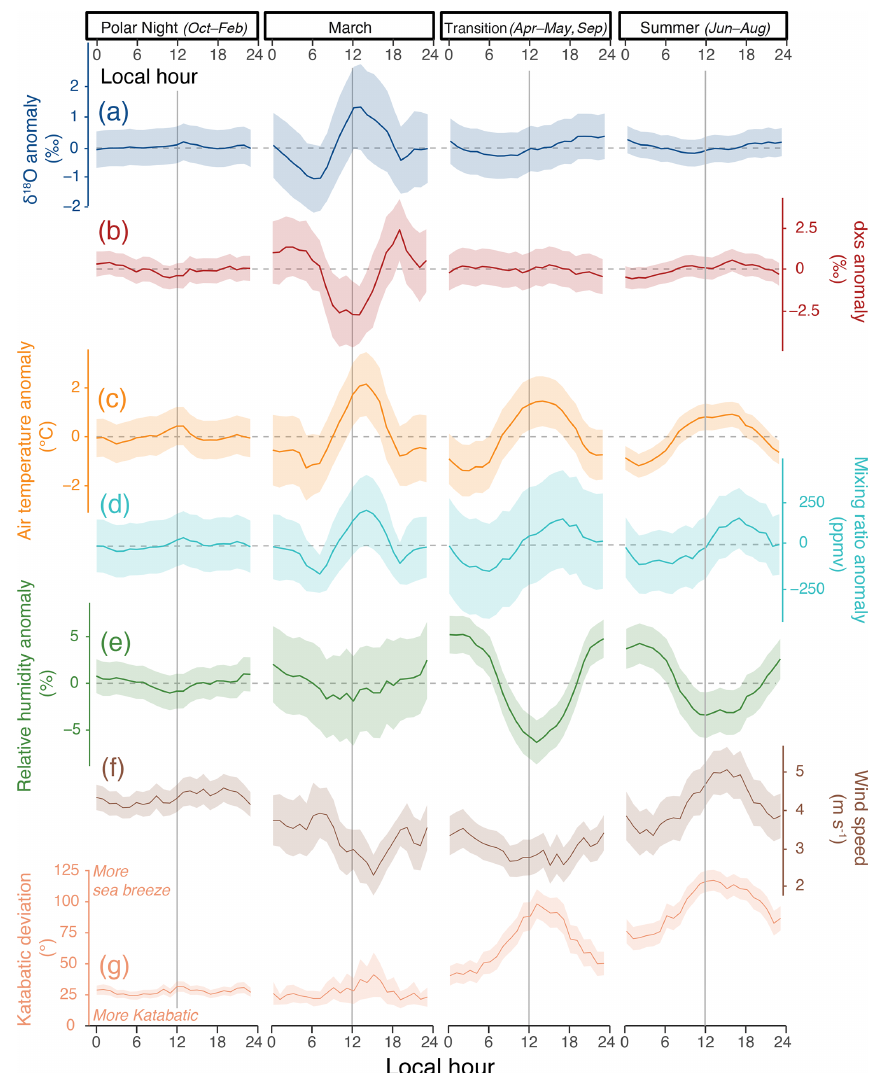
Figure 8. Diel patterns in isotopic (a, b) and meteorological (c–g) variables in Thule, Greenland, showing the mean hourly value (solid thick line) and 95% confidence intervals of mean estimates (colored shading) for each diel regime. Diel patterns for δ 2 H are very similar to δ 18 O (a) and are not shown. Variables other than wind speed and katabatic deviation are expressed as deviations from the mean value in each regime, with zero deviation indicated as a dashed horizontal line. Note that because the winds in Thule are binary (katabatic or sea breeze), the diel means of katabatic deviations should be viewed as a probability of being katabatic or sea breeze at a given time and not that the winds are smoothly transitioning from east to west or vice versa. Additionally, because katabatic deviations increase in value in both directions away from 100 ◦ (e.g., winds from 80 and 120 ◦ both have a katabatic deviation of + 20 ◦ ), the natural variance in purely katabatic winds produces an average value of ∼ 25 ◦ rather than 0 ◦